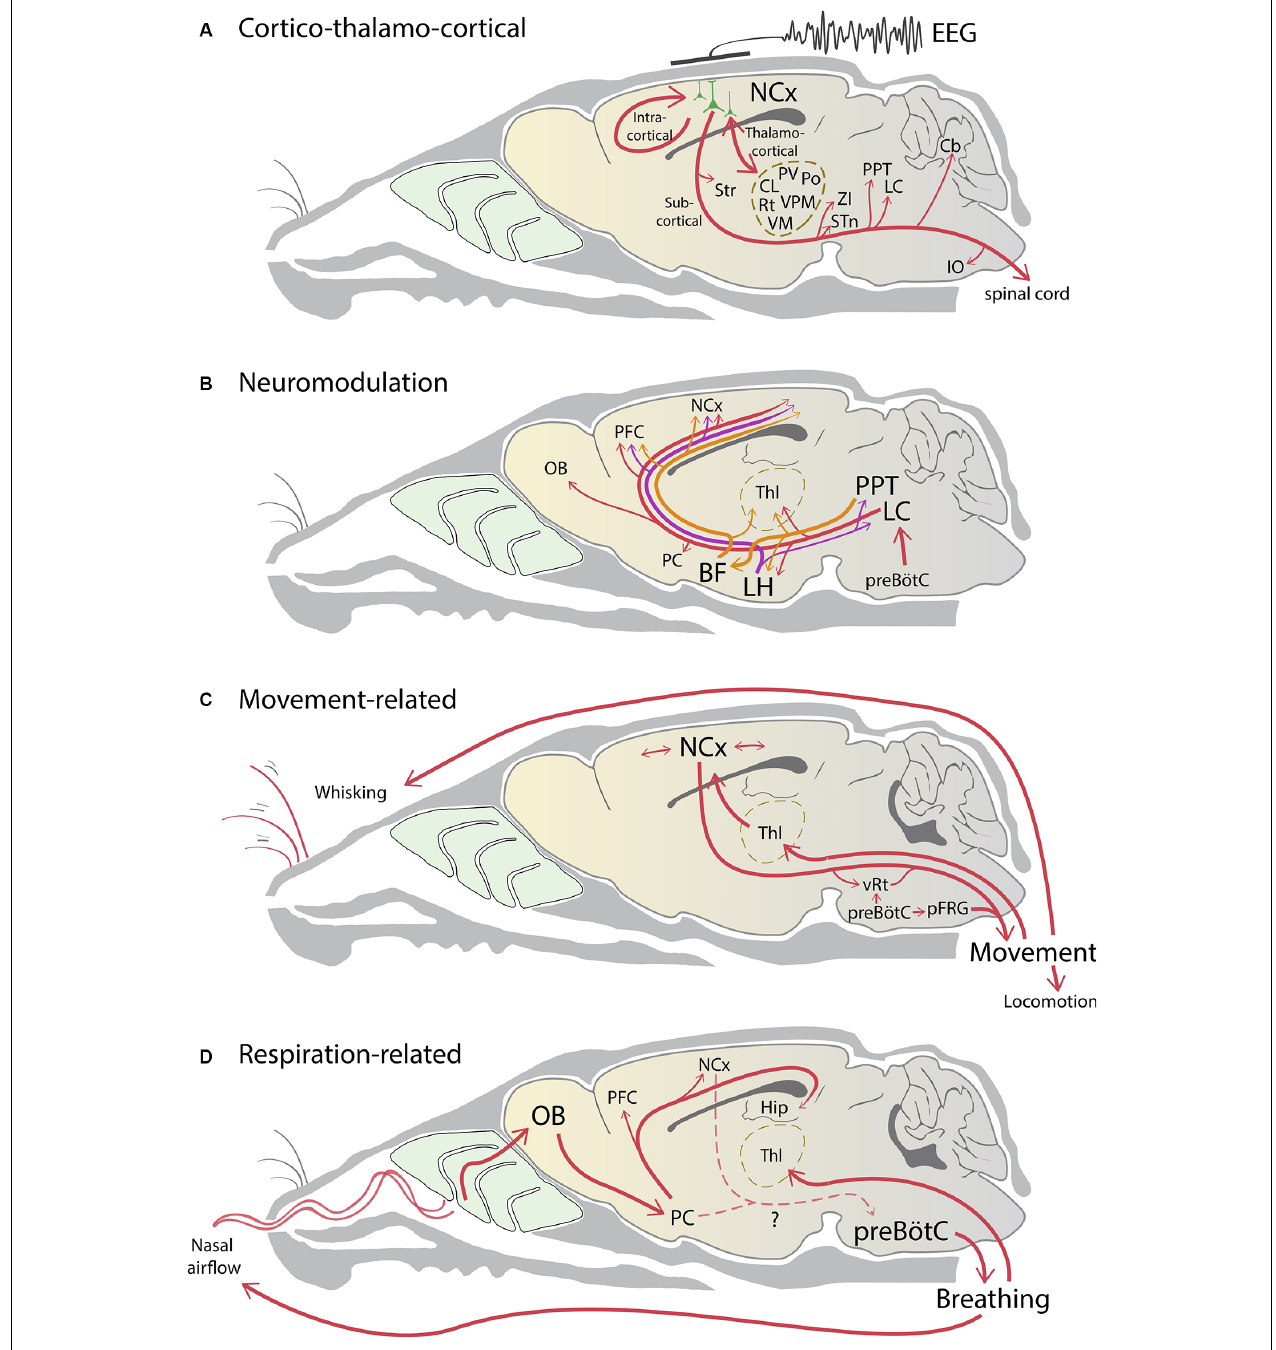
FIGURE 1 | Neural pathways influencing brain state changes. (A) Rhythmic excitatory activity reverberates within local and intracortical circuits in the neocortex (NCx). The aggregate cortical activity collaborates with thalamic activity to form a thalamocortical loop. The resultant spiking activity in phase with brain state is broadcasted to the rest of the brain via many subcortical projections of layer 5 pyramidal neurons. (B) Noradrenergic (red), cholinergic (orange), and orexinergic (purple) neuromodulatory pathways project widely across the brain to influence brain state changes. Respiratory activity in the preBötzinger complex (preBötC) is coupled to the noradrenergic system to influence arousal and wakefulness. (C) Neocortical circuits and brainstem central pattern generators drive movement which can change brain state. Movement itself generates sensorimotor information that sends feedback to the cortex via the thalamus and contributes to cortico-thalamocortical activity. (D) preBötC sets the rhythm of nasal airflow, which in turn entrains respiration-related slow oscillatory activity via the olfactory system. This activity propagates across the neocortex and contributes to rhythmic cortical activity. Respiration can be under either voluntary or involuntary control, however, the pathways linking the neocortex and the piriform cortex (PC) to the preBötC are unclear (dashed lines). Note that for simplicity arrows do not indicate direct